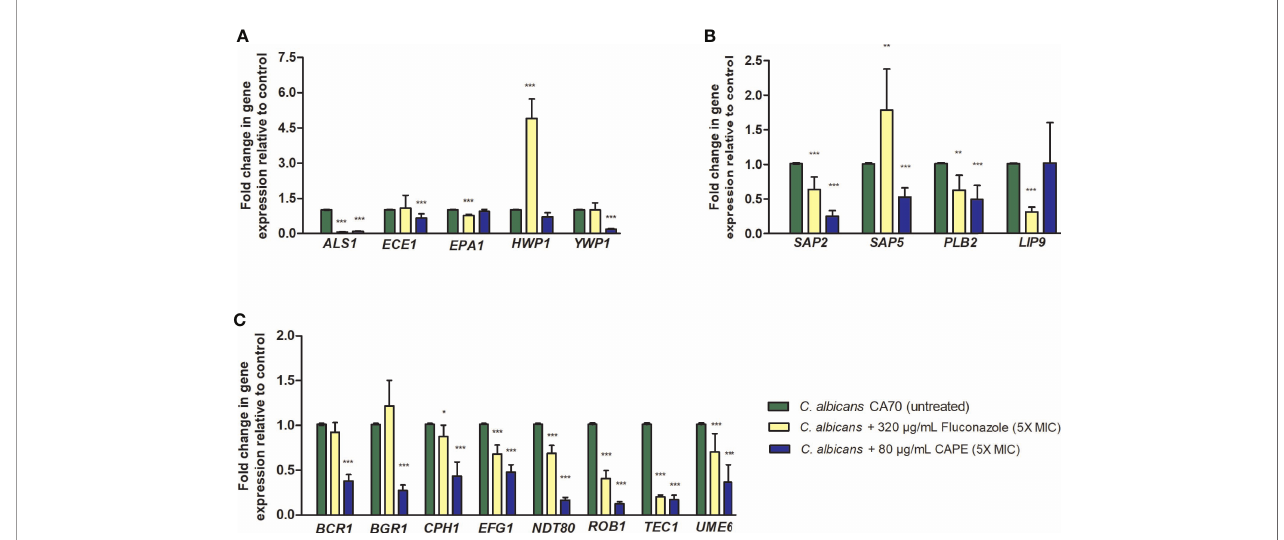
FIGURE 3 | Relative expression of C. albicans genes. (A) Relative quanti fi cation of ALS1, ECE1, EPA1, HWP1 , YWP1 genes for the non-treated control group (PBS) and treated groups with fl uconazole and CAPE (5 x MIC). (B) Relative quanti fi cation of SAP2 , SAP5 , PBL2 and LIP9 genes. (C) Relative quanti fi cation of BCR1,